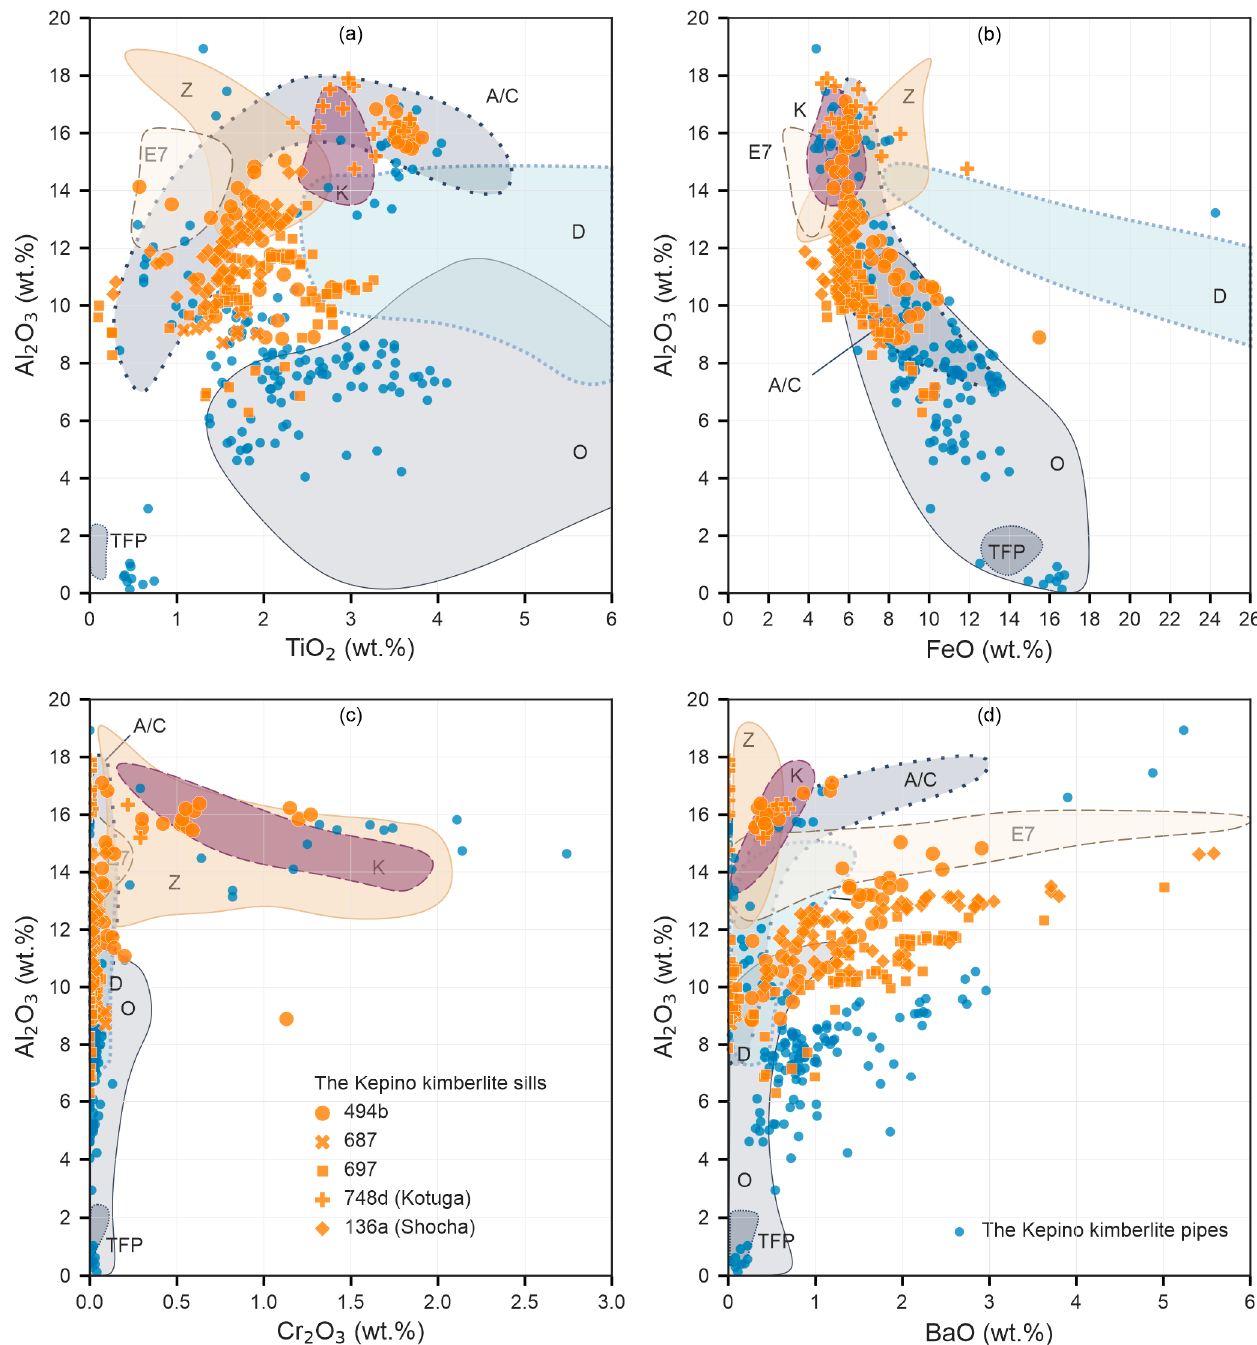
Figure 8. Bivariate plots Al 2 O 3 vs. FeO ( a ), Al 2 O 3 vs. Cr 2 O 3 ( b ), Al 2 O 3 vs. TiO 2 ( c ), Al 2 O 3 vs. BaO ( d ) for the phlogopite from the Kepino cluster kimberlites with detalisation for kimberlite sills. The “K” field is for phlogopite phenocrysts and microphenocrysts from pyroclast groundmass and kimberlite matrix from the Grib kimberlite, ADP, based on [57]. The “O” field is for phlogopite from orangeites of Kostomuksha, Karelia, Russia, based on [60]. The “Z” field is for phenocrysts and microphenocrysts kimberlites of the Zolotica cluster, ADP (Supplementary Materials, Table S2). The “E7” field is for phlogopite from Ermakovskaya-7 pipe, Kola Peninsula (Supplementary Materials, Table S2). “A/C”, “D” and “TFP” fields are for phlogopite from ultramafic lamprophyres and carbonatites from Aillik Bay, Canada, based on [59]: “A/C”—aillikites and carbonatites; “TFP”—tetraferriphlogopite rims from aillikites; “D”—damtjernites and mela-aillikites. Phlogopites from kimberlites from 688 and Kotuga pipes and Kotuga sill, presented as large macrocrystic or phenocrystic phlogopite grains, have concentrations of Al 2 O 3